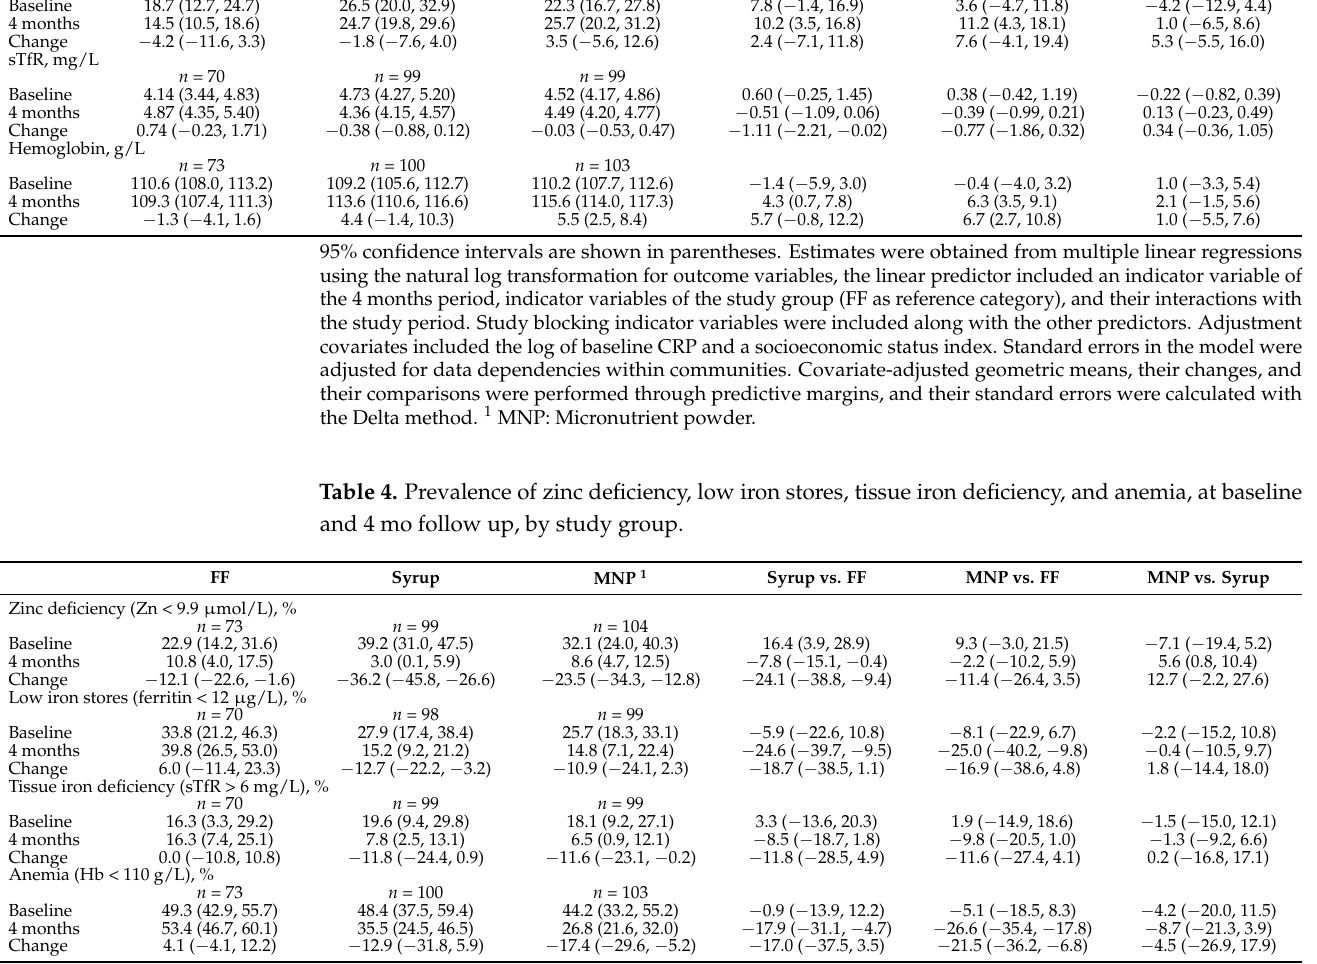
adjustment for unbalanced characteristics between groups at baseline (Supplementary Materials: Tables S2 and